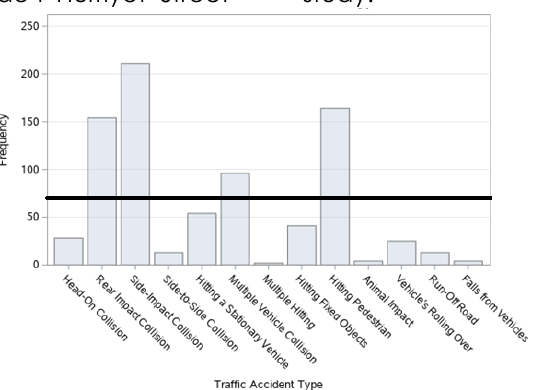
Figure 17. Bar graph of traffic accidents on Büyükdere Street in Şişli district by accident type.